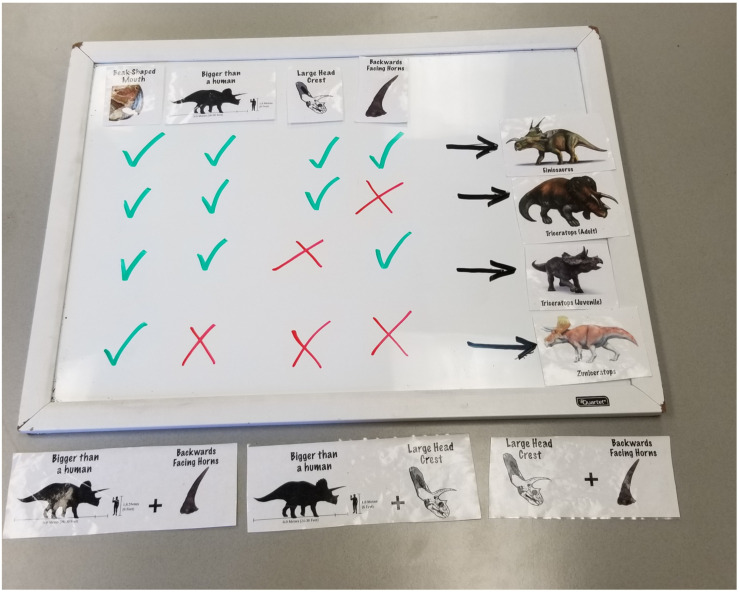
Completed grid for the dinosaur task. The experimenter would first explain and place the traits as column headers, then add checks and Xs with whiteboard markers to characterize the dinosaurs. The three answer choices appear at the bottom.